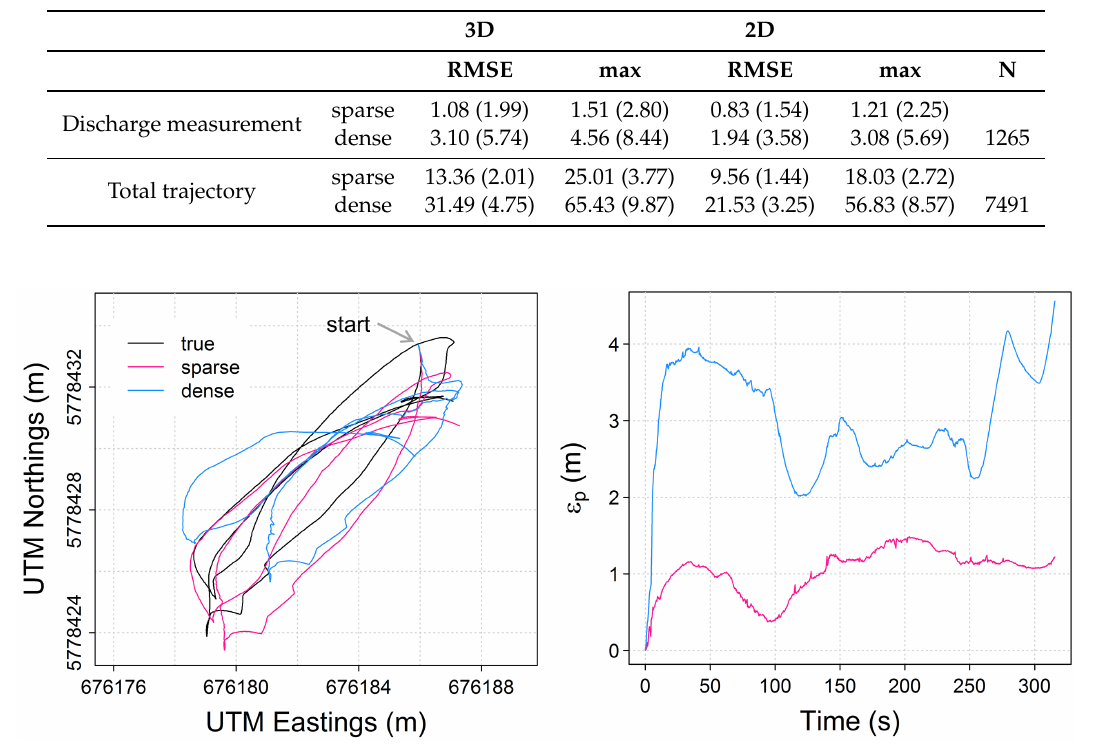
Table 2. Root mean square error ( RMSE ) and maximum of the 3D and 2D position errors, for the discharge measurement track of four consecutive river crossings and the full test trajectory; errors are given in m and % of track length (in brackets); N stands for the sample size of registered stereo image frames.